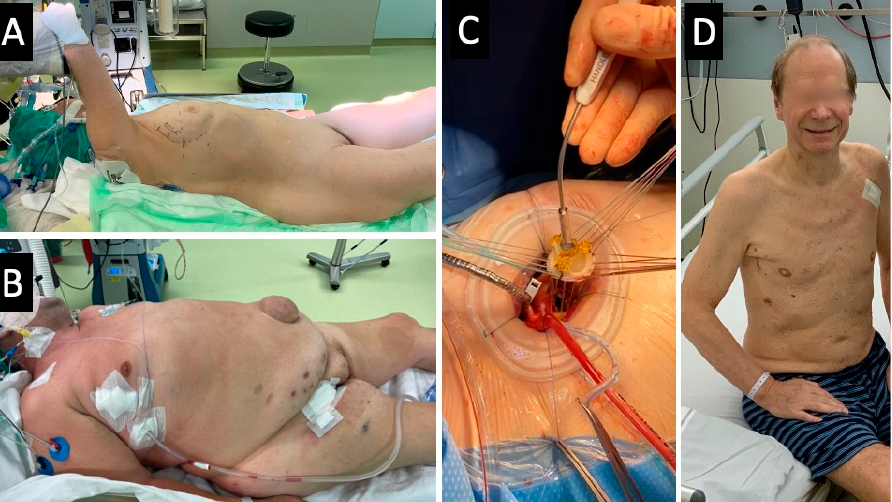
Figure 2. ( A ) Intraoperative setup in a slender female. ( B ) Immediate postprocedural aspect in a BMI 46 kg/m 2 male. ( C ) Intraoperative aspect during implantation of a sutured bioprosthesis. ( D ) Postoperative cosmetic result in a male patient .